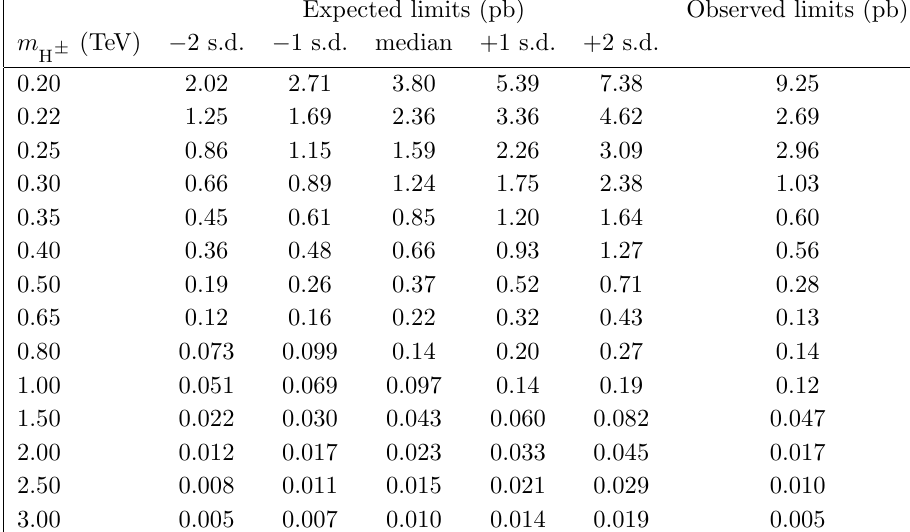
B (H (cid:6) ! tb) with the combined all-jet, single- H (cid:6) t(b)